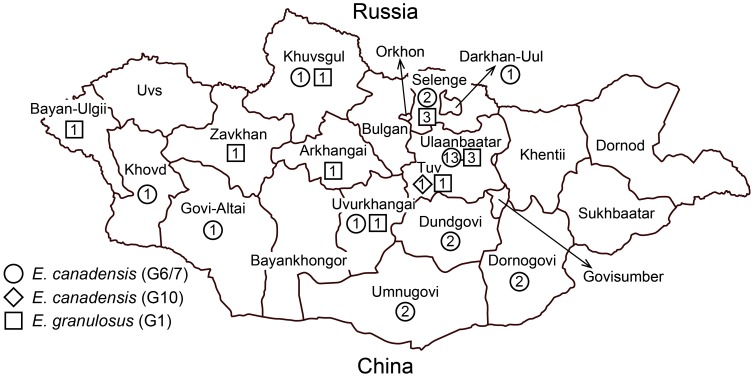
A map of Mongolia showing the distribution of 39 CE cases caused by E. canadensis (G6/7) (n = 26), E. canadensis (G10) (n = 1), and E. granulosus s.s. (G1) (n = 12).Additional four cases had no record of province (see Table 1).